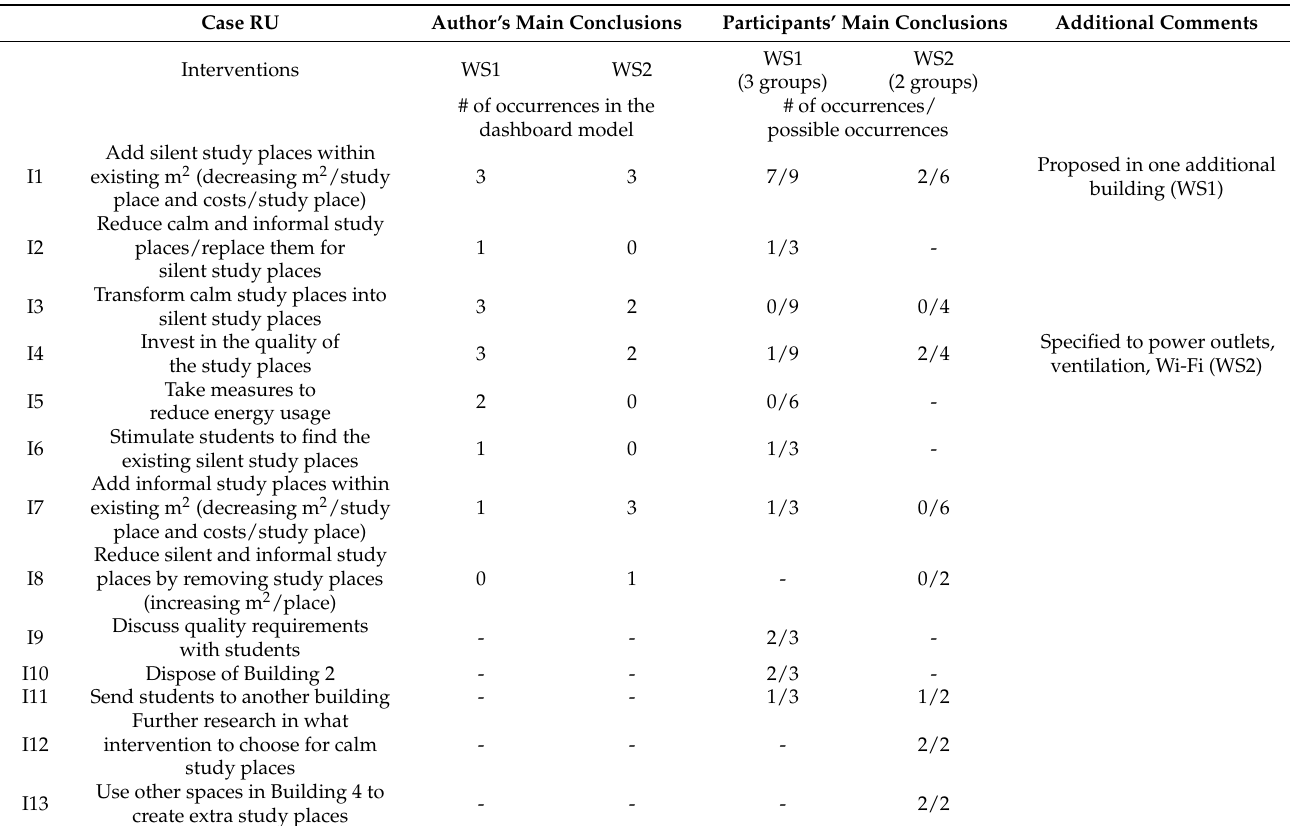
Table 3. Interventions in case RU. Workshops 1 and 2 are abbreviated as WS1 and WS2. Case RU